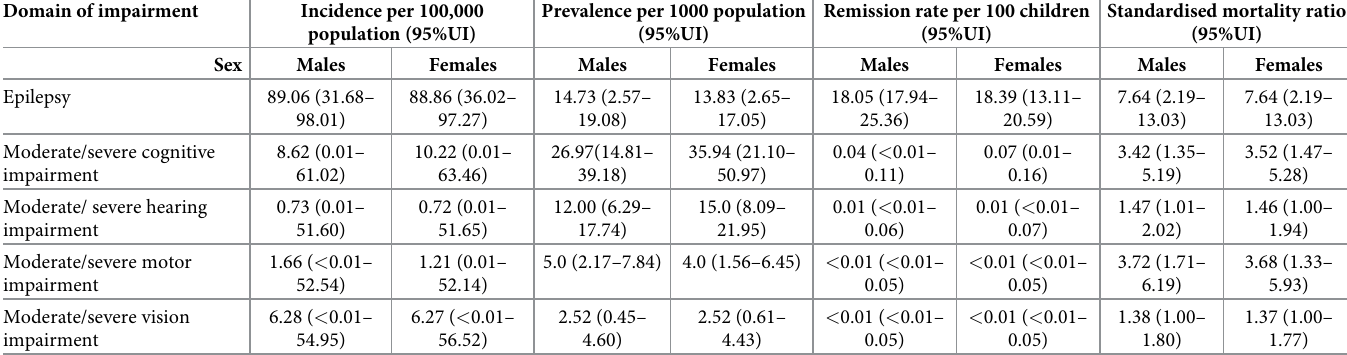
Table 1. Modelled incidence, prevalence, remission, and mortality parameters by sex and domain of neurological impairment for children aged 5–14 years in Kilifi, Kenya (N = 86,360). Domain of impairment